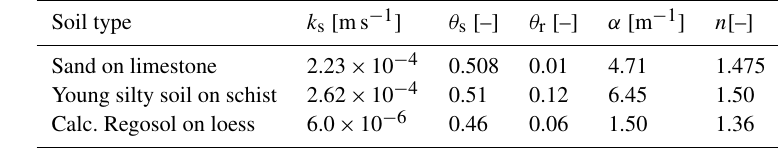
Table 2. Characteristics of the numerical benchmarks: rainfall input P , initial condition θ ini , and simulation time t sim . Soil type Wetting Wetting Wetting Wetting and drying Sand P = 20mm in 1h θ ini = uniform t sim = 1h Silty soil P = 20mm in 1h θ ini = uniform t sim = 1h P = 20mm in 1h Calc. θ ini = S-shaped Regosol t sim = 1h